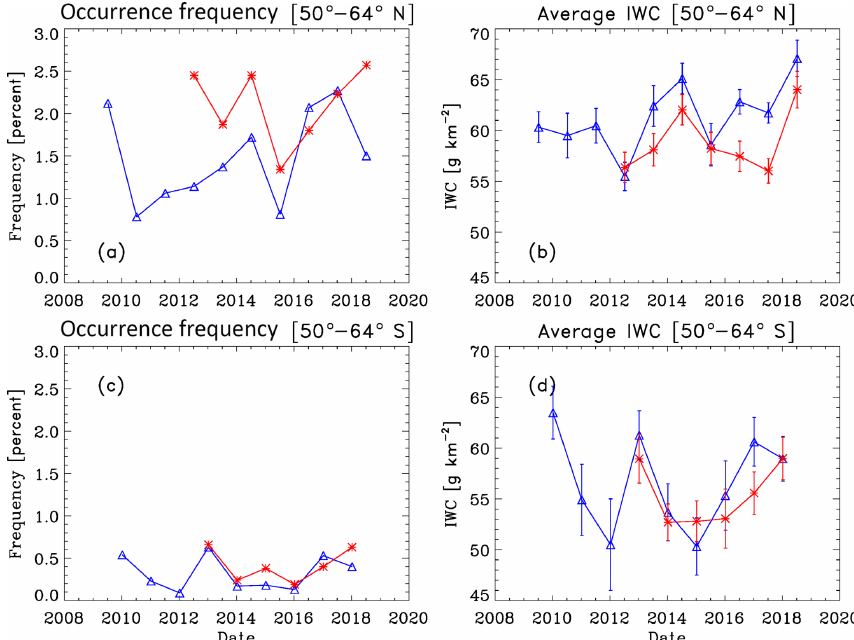
Figure 4. Season average PMC occurrence frequency and ice water content data at 50–64 ◦ latitude. Blue denotes NOAA-19 SBUV/2, and red denotes S-NPP OMPS. (a, c) Occurrence frequency (%) and (b, d) IWC (gkm − 2 ). (a, b) Northern Hemisphere and (c, d) Southern Hemisphere. Average SZA and local time values for each instrument during each season are listed in Table 1.